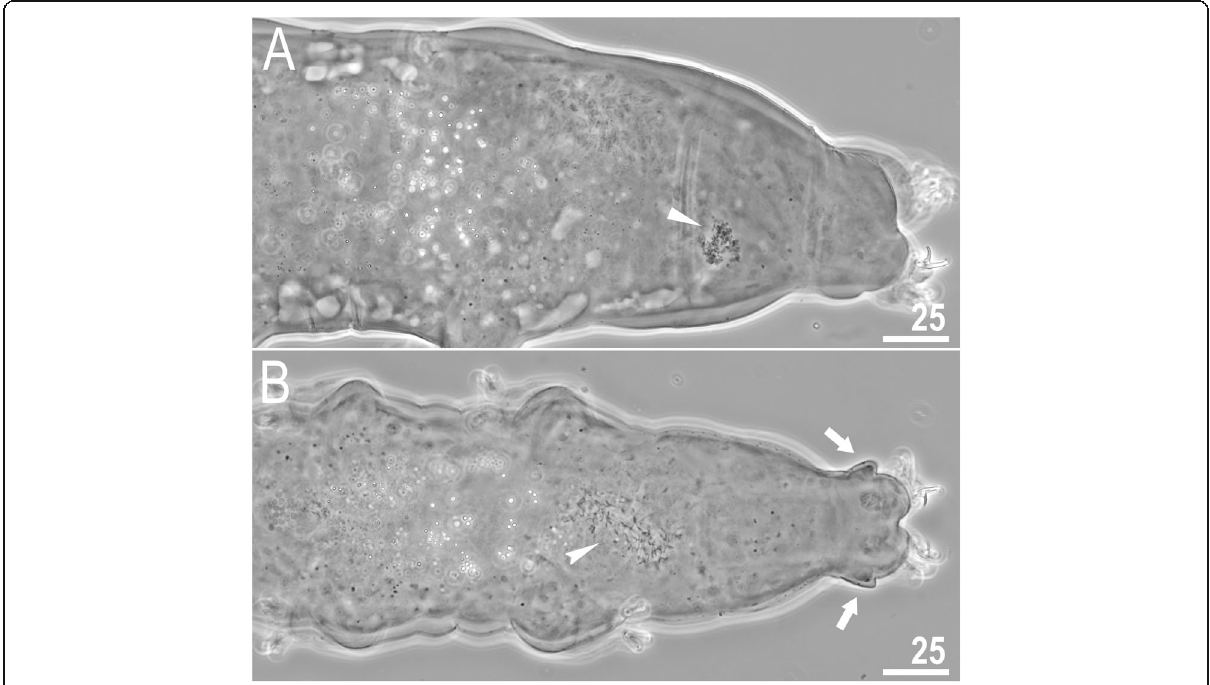
Fig. 29 Macrobiotus ripperi sp. nov. from Poland (PL.015) – reproduction (LCM): a – spermatheca (seminal vesicle) filled with spermatozoa and visible in females freshly mounted in Hoyer ’ s medium; b – testis filled with sperm visible in a male freshly mounted in Hoyer ’ s medium. The flat arrowhead indicates the female spermathecae, the indented arrowhead indicates the testis, and arrows indicate gibbosities on the IV legs. Scale bars in μ